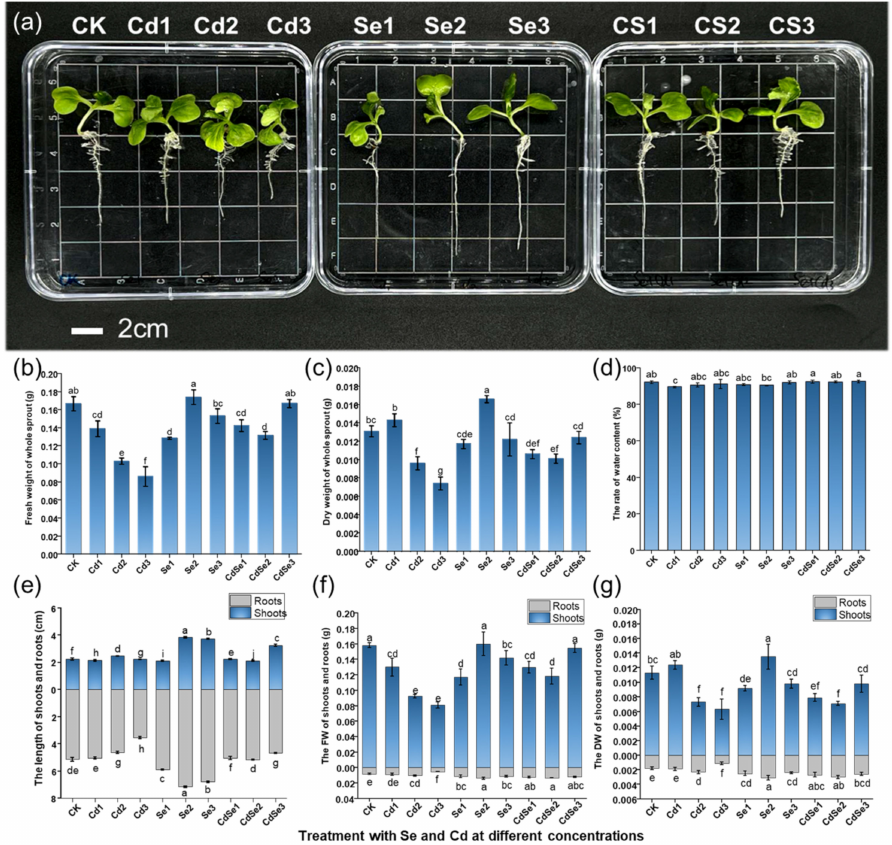
Figure 1. The effects of Na 2 SeO 3 and CdCl 2 treatment on the growth of B. juncea seedlings. The white bar represents the 2 cm length in the picture. Five seedlings were randomly selected for parameter measurements and the average values were taken. The measurements were repeated three times for each treatment. The error bar represents the standard deviation in the histogram. The lowercase letter a to j on the bar reflects the 5% significance level. ( a ) Growth morphology of B. juncea seedlings under different treatment conditions; ( b ) the fresh weight of whole seedlings; ( c ) the dry weight of whole seedlings; ( d ) the percentage of seedling water content; ( e ) the root and shoot lengths of seedlings under different treatments; ( f ) the fresh weight of seedling roots and shoots; and ( g ) the dry weight of seedling roots and